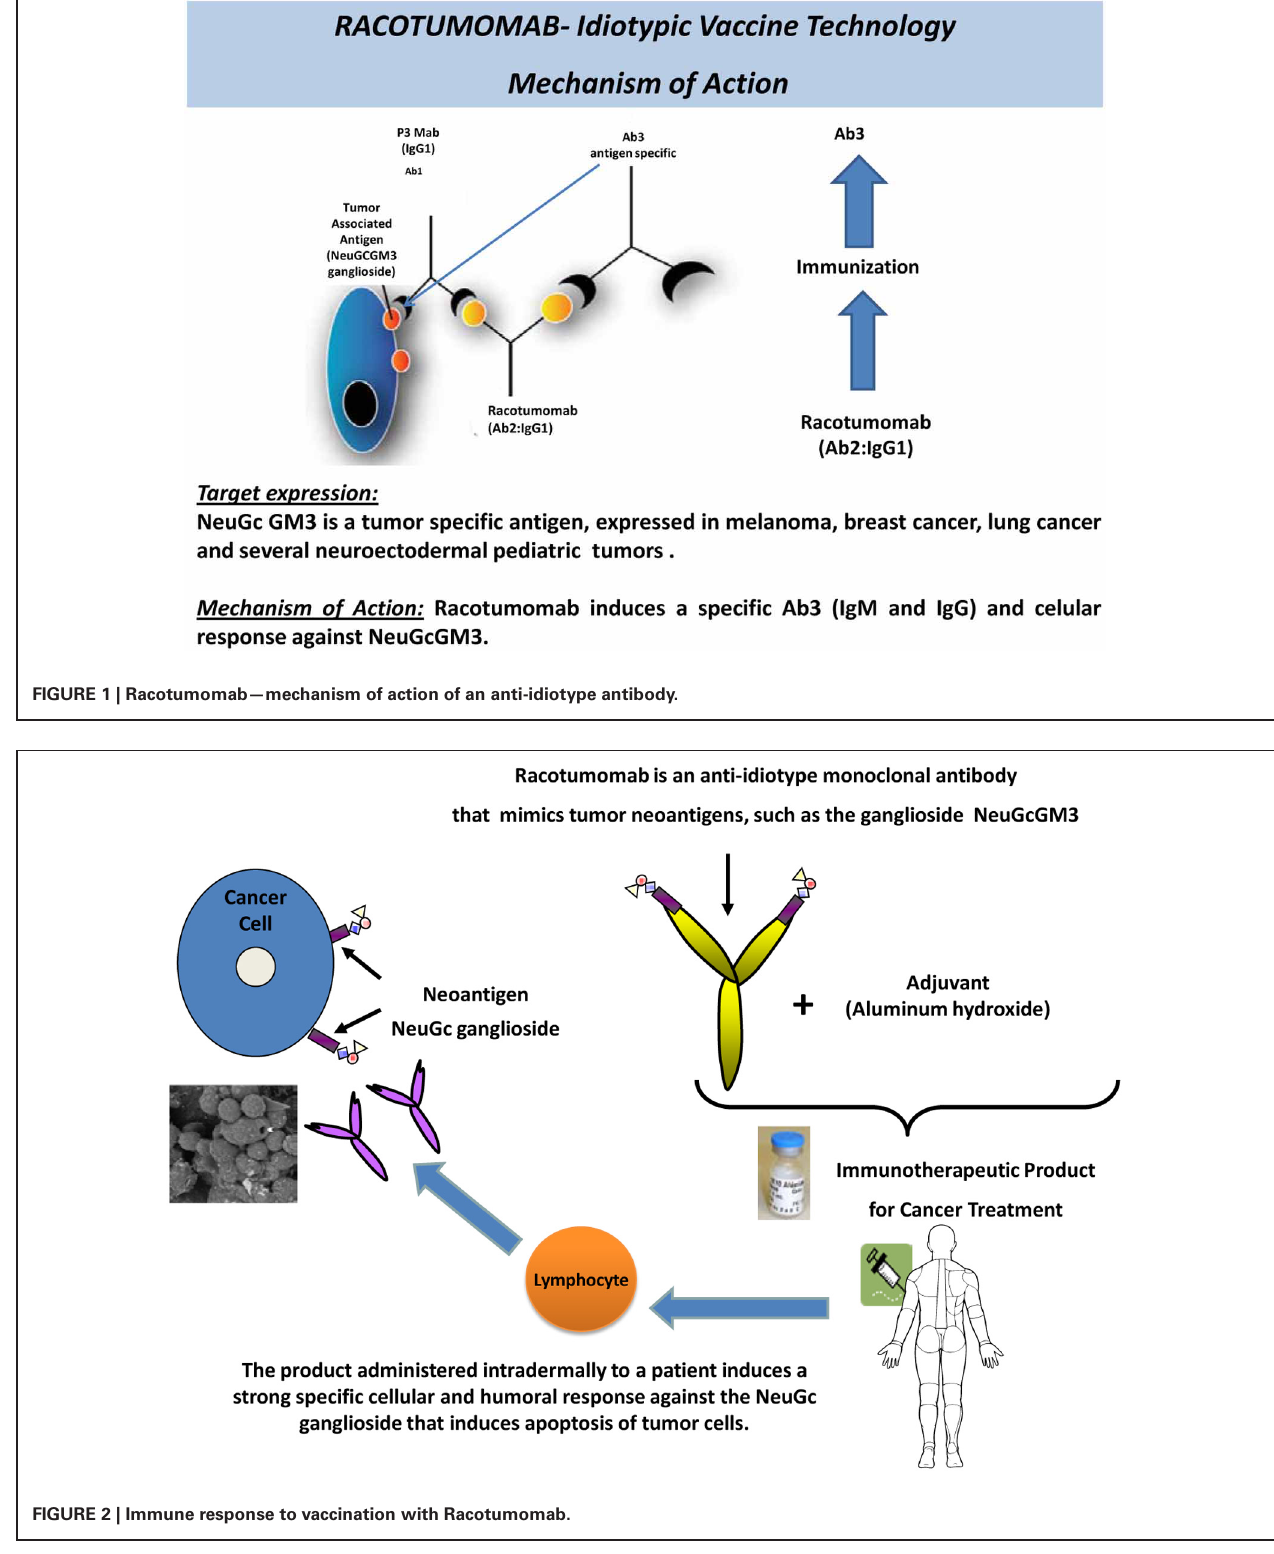
Frontiers in Oncology | Tumor Immunity October 2012 | Volume 2 | Article 147 |